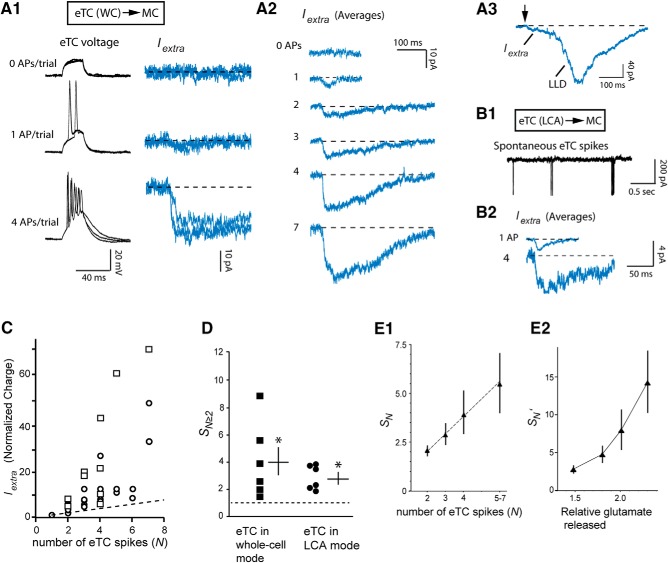
Supralinear increase in extrasynaptic excitatory currents. A, Example whole-cell recordings from an eTC-MC pair illustrating MC current responses to different numbers of action potentials (APs) in the eTC. eTC spikes were evoked by direct depolarizing current pulses (500 pA, 25 ms). Note in the raw traces (A1; three superimposed trials) and averages (A2) that the total current associated with Iextra for more than or equal to two eTC spikes was much larger than linear summation of the current driven by one AP. In one of the trials in which the eTC spiked seven times in the same experiment (A3), the MC response included a distinct, much larger LLD event ∼150 ms after the onset of Iextra (note scale bar). B, Another eTC-MC pair recording in which the number of spikes in the eTC recorded in the LCA mode (B1; raw example trace) was related to Iextra in the MC (B2; averages). C, Summary of Iextra measurements from 12 pair recordings versus number of spikes in the eTC (N). Values, which reflect experiments in which the eTCs were in whole-cell (open squares) or LCA (open circles) patch modes, were normalized to the charge elicited by one eTC spike in the same pair. Note that nearly all points lie above the dashed line, which reflects linear summation of Iextra elicited by one eTC spike. Most pair recordings contributed multiple data points to the plot. D, Supralinearity indices SN measured across 12 pair-cell recordings separated by recording type for the eTC. A single value is plotted for each pair-cell recording, reflecting the average Iextra measured whenever the eTC fired at least two spikes (N ≥ 2). Asterisks: p ≤ 0.041 in comparison to SN≥2 = 1 (linear), paired t tests. Lines reflect mean ± SEM for each recording type. E1, Supralinearity indices SN (mean ± SEM) sorted by the number of spikes in the eTC. Each data point reflects 8–10 recordings obtained when the eTC was in either whole-cell or LCA patch mode. Superimposed line reflects fit of the individual SN values across all experiments, which yielded a significant correlation coefficient (0.37, p = 0.031). E2, Similar to part E1, except that values for the supralinearity indices were adjusted (yielding SN’) for the relative amount of glutamate released across different numbers of eTC spikes. Glutamate release was estimated from EPSCs recorded in eTC-PG cell pairs (Fig. 6); x-axis values reflect estimates of the amount of glutamate release following two, three, four, or five to seven eTC spikes, normalized to the single spike-evoked release in the same recording.